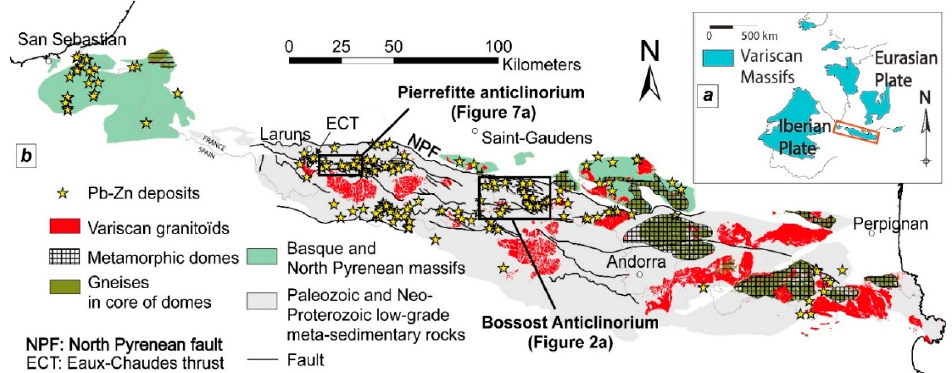
Figure 1. ( a ) Location of the Pyrenean Axial Zone (PAZ) within the Variscan belt of Western Europe. ( b ) Schematic map of the Pyrenean Axial Zone (PAZ) and location of all recognized Pb-Zn deposits (based on BRGM (French geological survey) and IGME (Spanish geological survey) databases). Note the abundance of these deposits especially in the central and western domains of the PAZ.